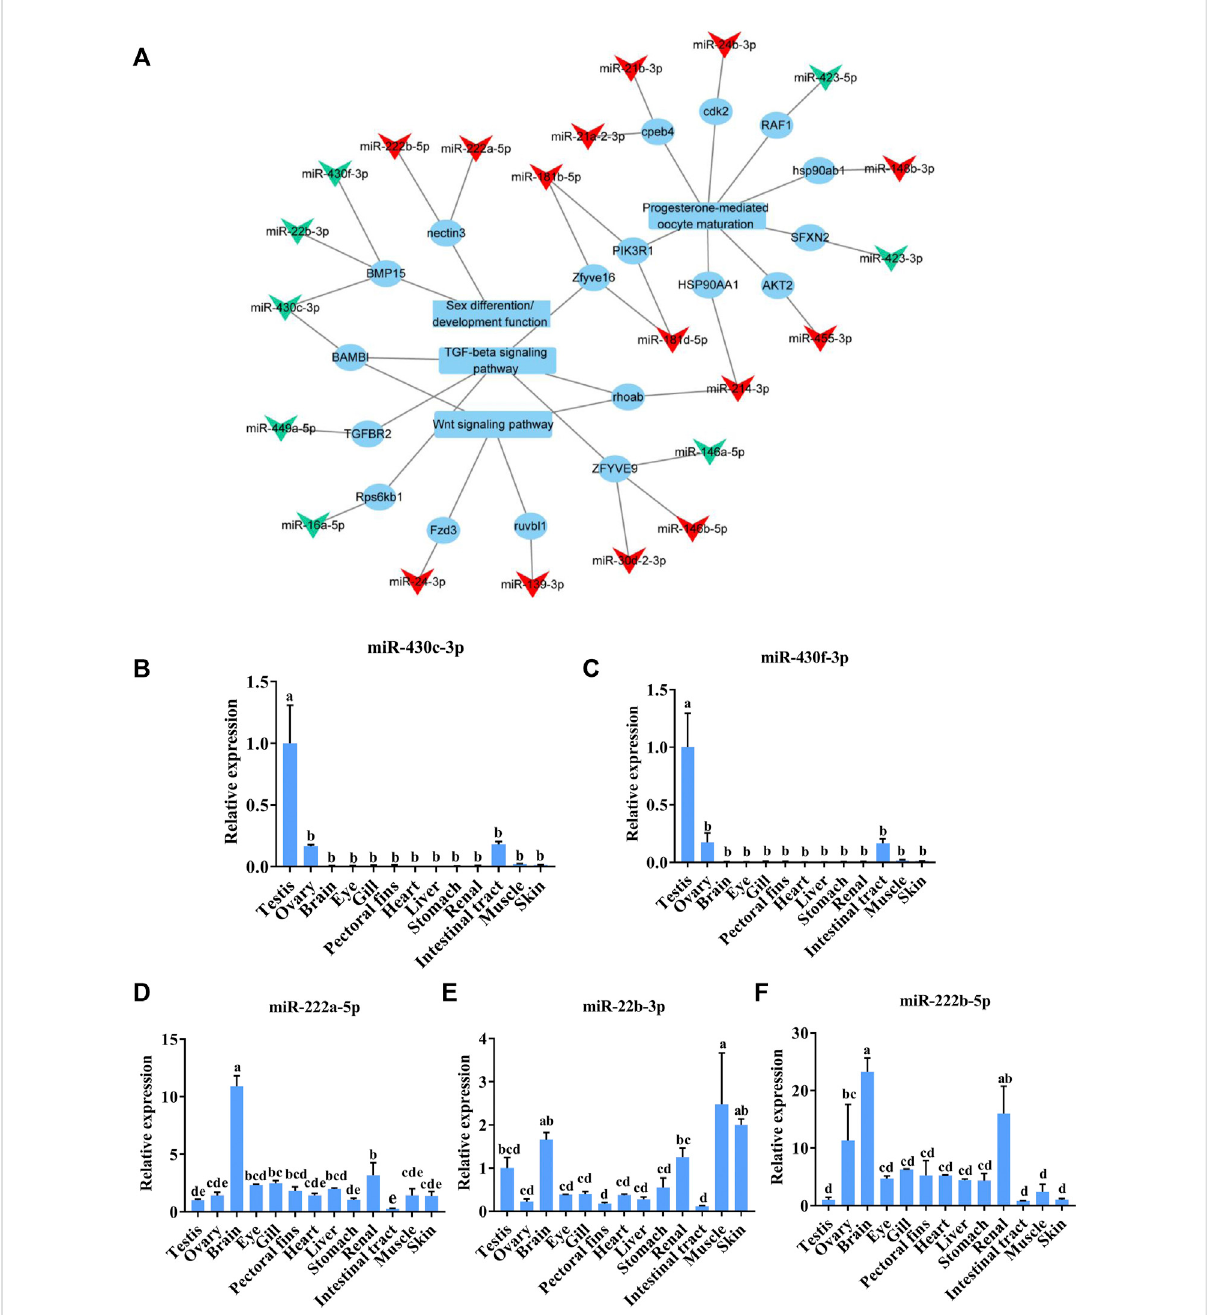
FIGURE 5 Analysis of sex-related DE-miRNAs in Collichthys lucidus . (A) The regulatory network of DE-miRNAs and sex-related genes, functions, and pathways. The triangular nodes represent miRNAs, the circular nodes represent mRNAs, and the quadrangular nodes represent functions and pathways. The red and green nodes represent up- and downregulated RNAs in the ovary compared to those in the testis, respectively. (B – F) The expression of sex-related candidate miRNAs was veri fi ed via qRT-PCR in various C. lucidus organs. Three biological replicates were performed foreachexperiment.One-wayANOVAwithTukey ’ sHSDposthoctest.Thedifferenceisinsigni fi cantifthereisonemarkedwiththesamelowercase letter ( p > 0.05), and the difference is signi fi cant if there is a different marked lowercase letter ( p <